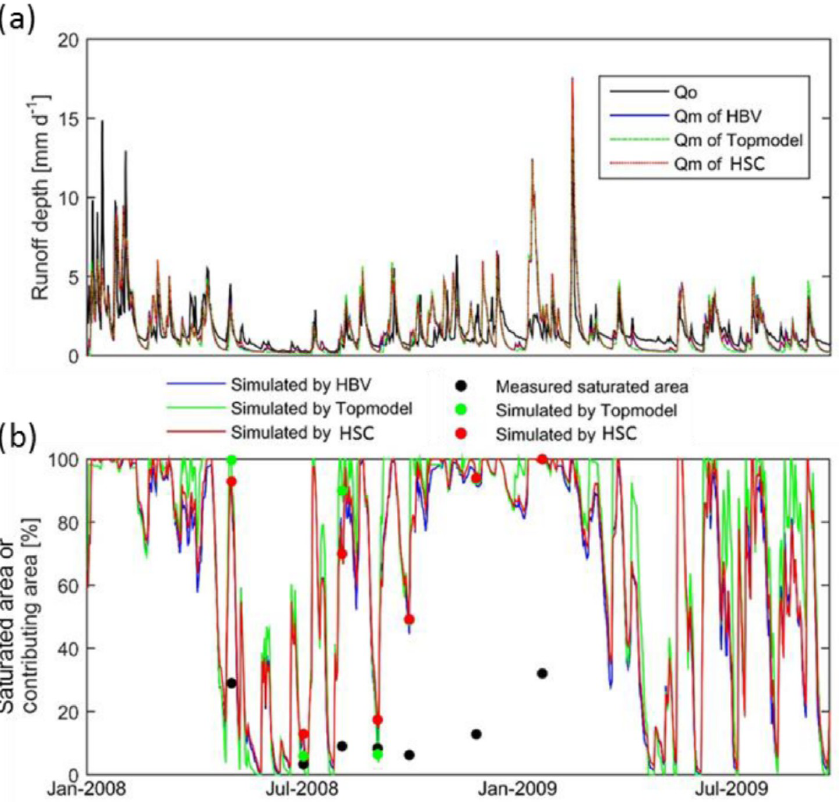
Figure 9. (a) The observed hydrograph (Qo, black line) of the Bruntland Burn catchment in 2008, and the simulated hydrographs (Qm) by the HBV model (blue line), TOPMODEL (green dash line), and HSC model (red dash line); (b) the comparison of the observed saturated area of 7 days (black dots) and simulated relative soil moistures, i.e., HBV (blue line), TOPMODEL (green line and dots), and HSC (red line and